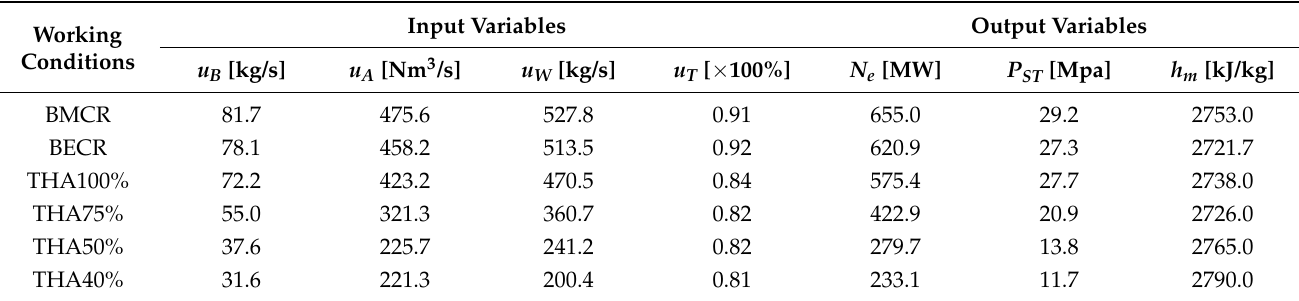
Table 2. The working conditions of the 660-MW USC CFB unit.